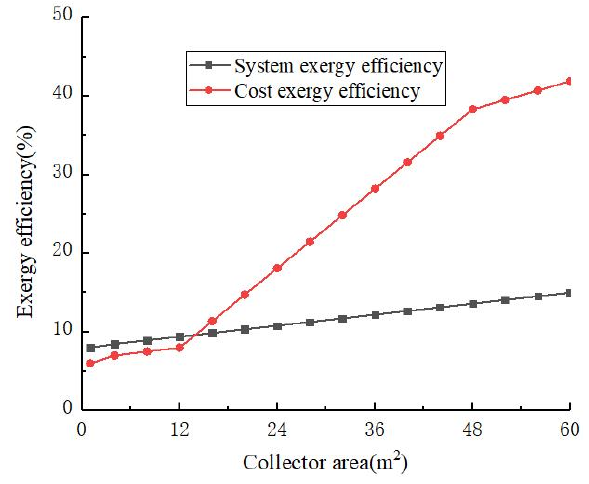
Figure 6. The exergy efficiency changes with the area of solar collectors.